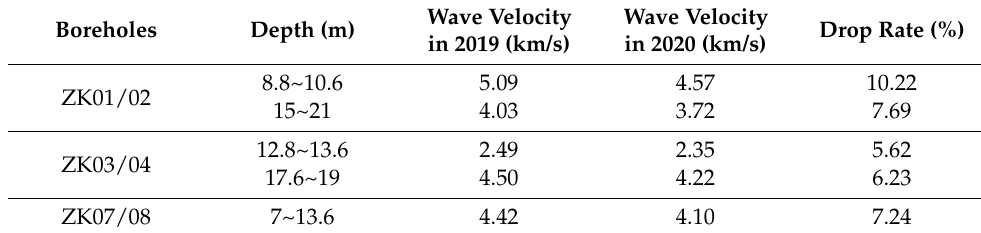
Table 3. Wave velocity of the sandstone section.